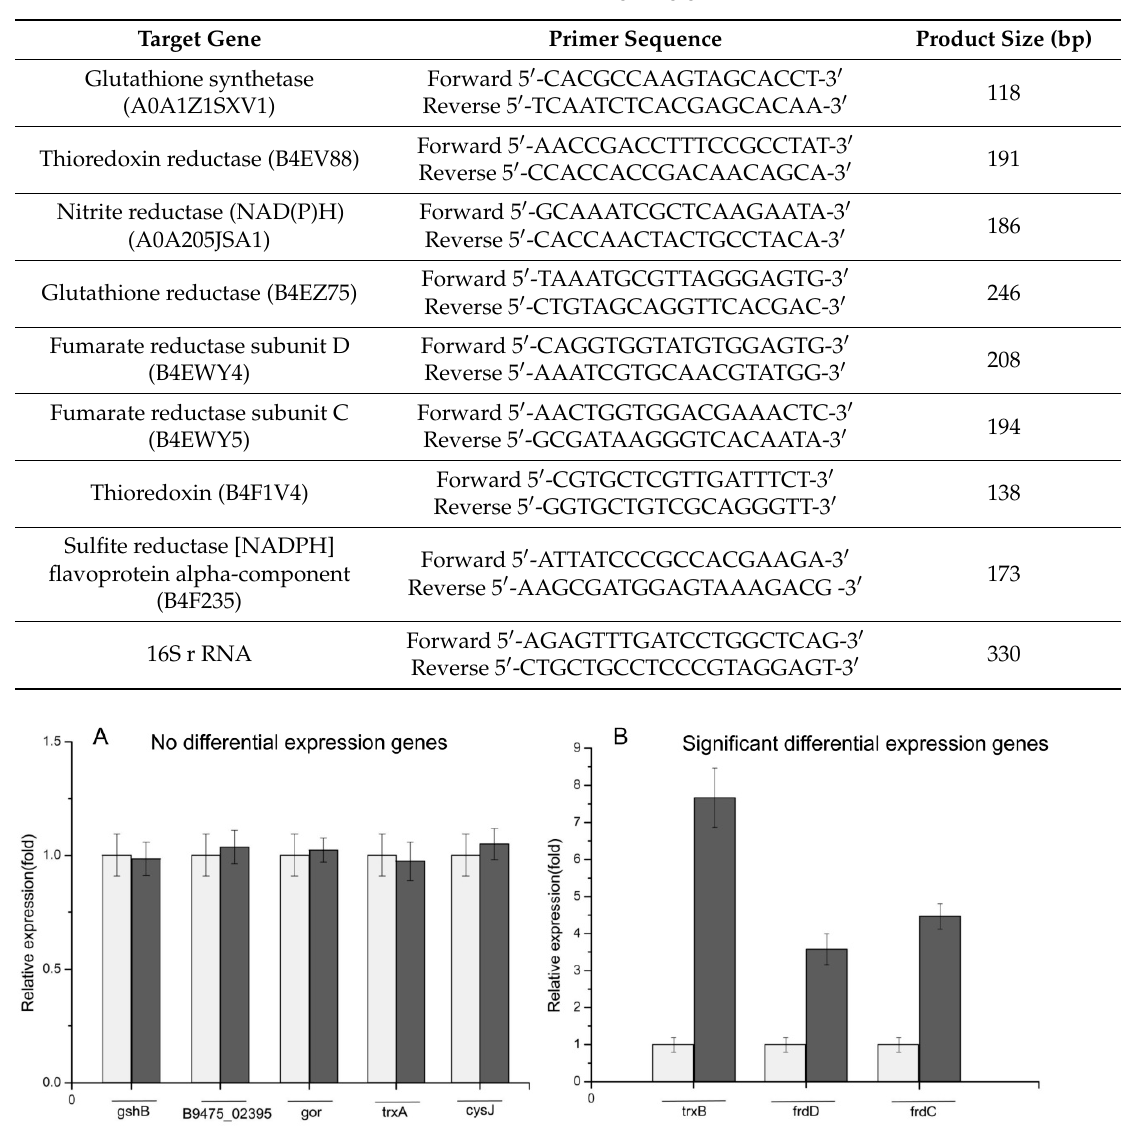
Table 2. Primers for targeting genes.